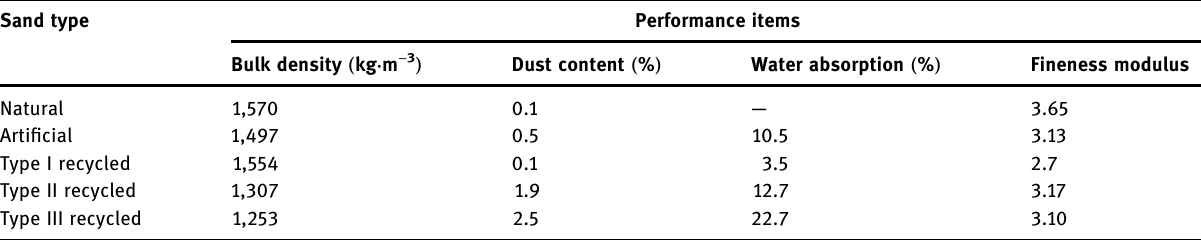
Table 1: Performance indicators of recycled sand and natural sand Sand type